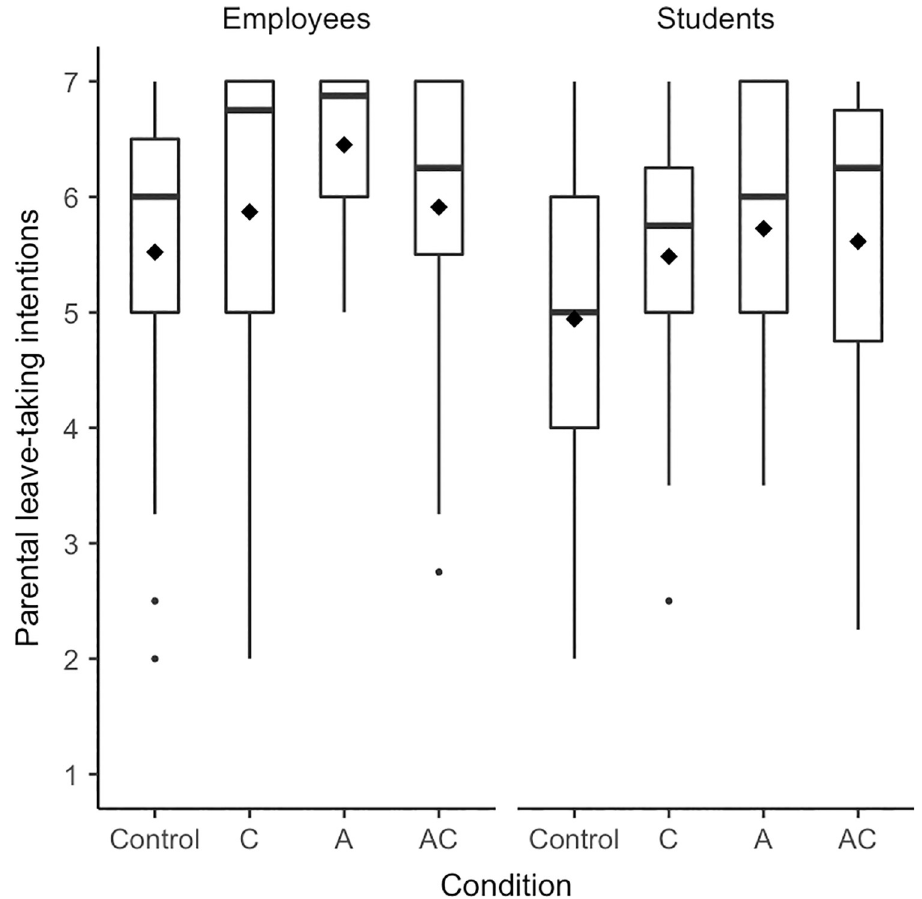
Fig 5. Boxplots for parental leave-taking intentions separated by condition and employment status (Experiment 2). (A) Employees. (B) Students. Diamonds represent means, horizontal lines represent medians.